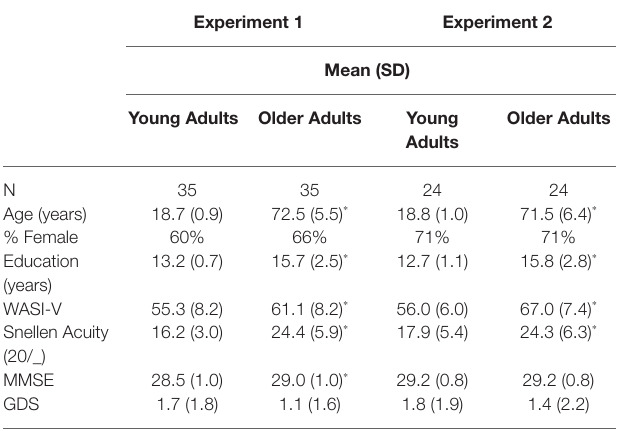
TABLE 1 | Participant characteristics for Experiments 1 and